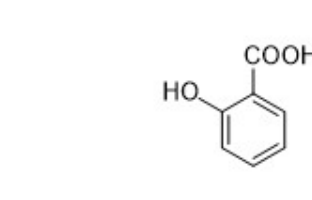
Figure 3. Chemical structure of different types of phenolic acids (hydroxycinnamic acids are hydroxy metabolites with a C6-C3 backbone, and hydroxybenzoic acid is a monohydroxy benzoic acid carrying a hydroxy substituent at C4 of the benzene